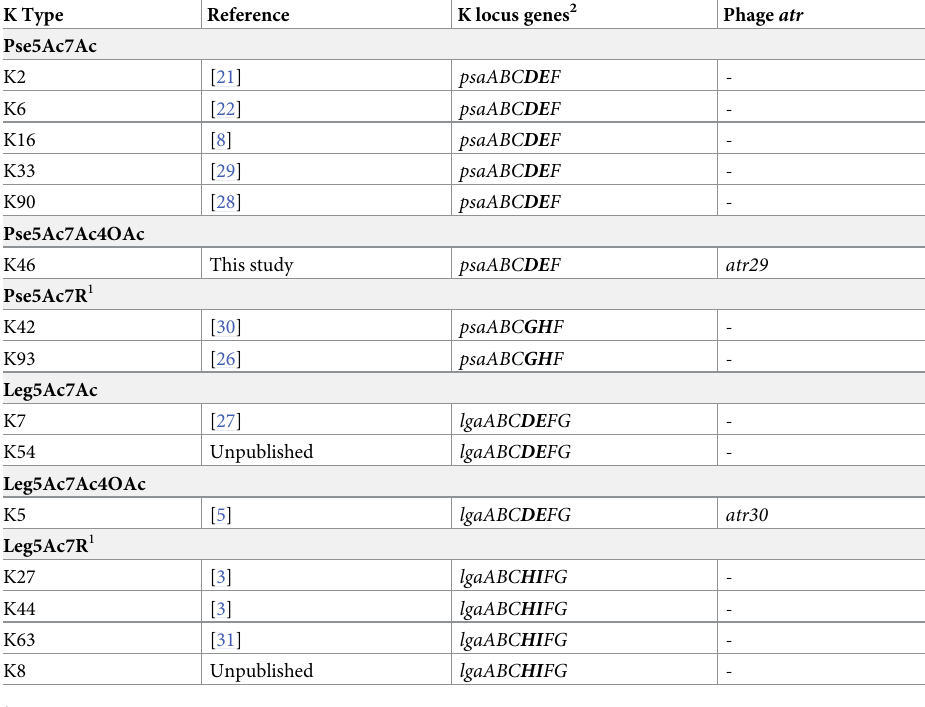
Table 2. Pseudaminic acid and legionaminic acid